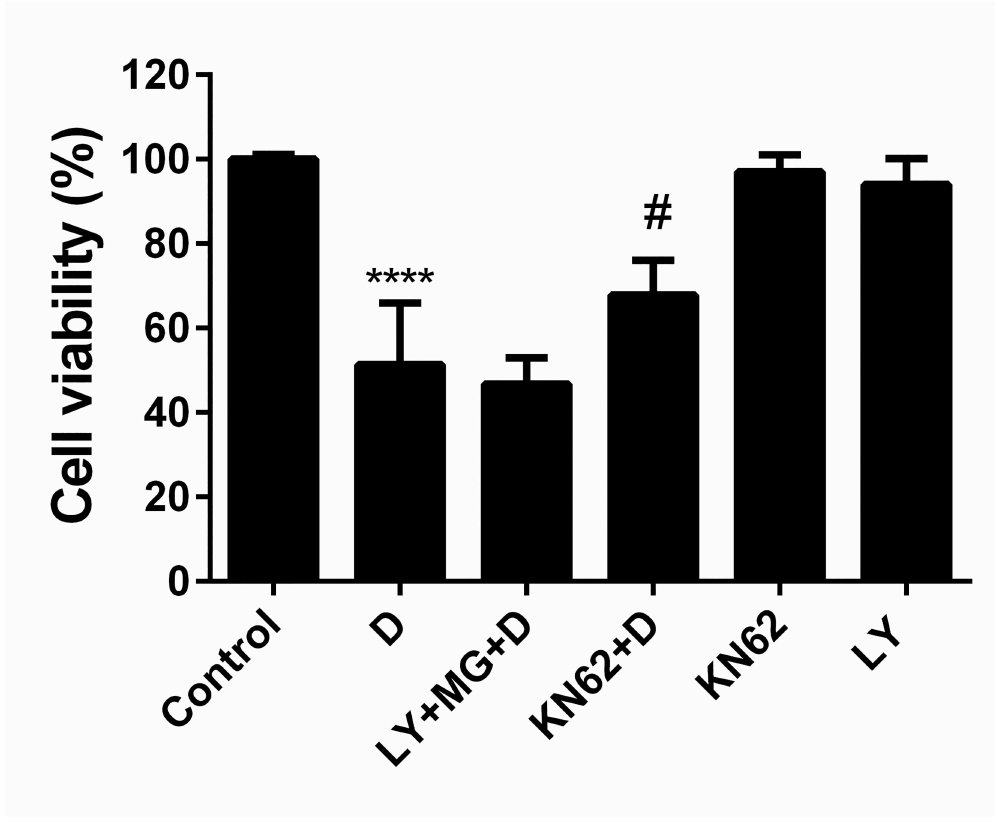
Fig 6. GB exert its protective effect by activating the PI3K/Akt pathway and inhibiting the CaMKII pathway. Cardiomyocytes cell viabilityanalysiswas determinedby MTT assay. PI3K inhibitorLY294002(10 μ M) pretreatment inhibitedthe protective effect of GB pretreatmentin DOX inducedcardiotoxicity while CaMKII inhibitor KN62 (10 μ M) pretreatmentsignificantly increasedcell viability. **** p < 0.0001 when compared to control group, #p < 0.01when comparedto DOX